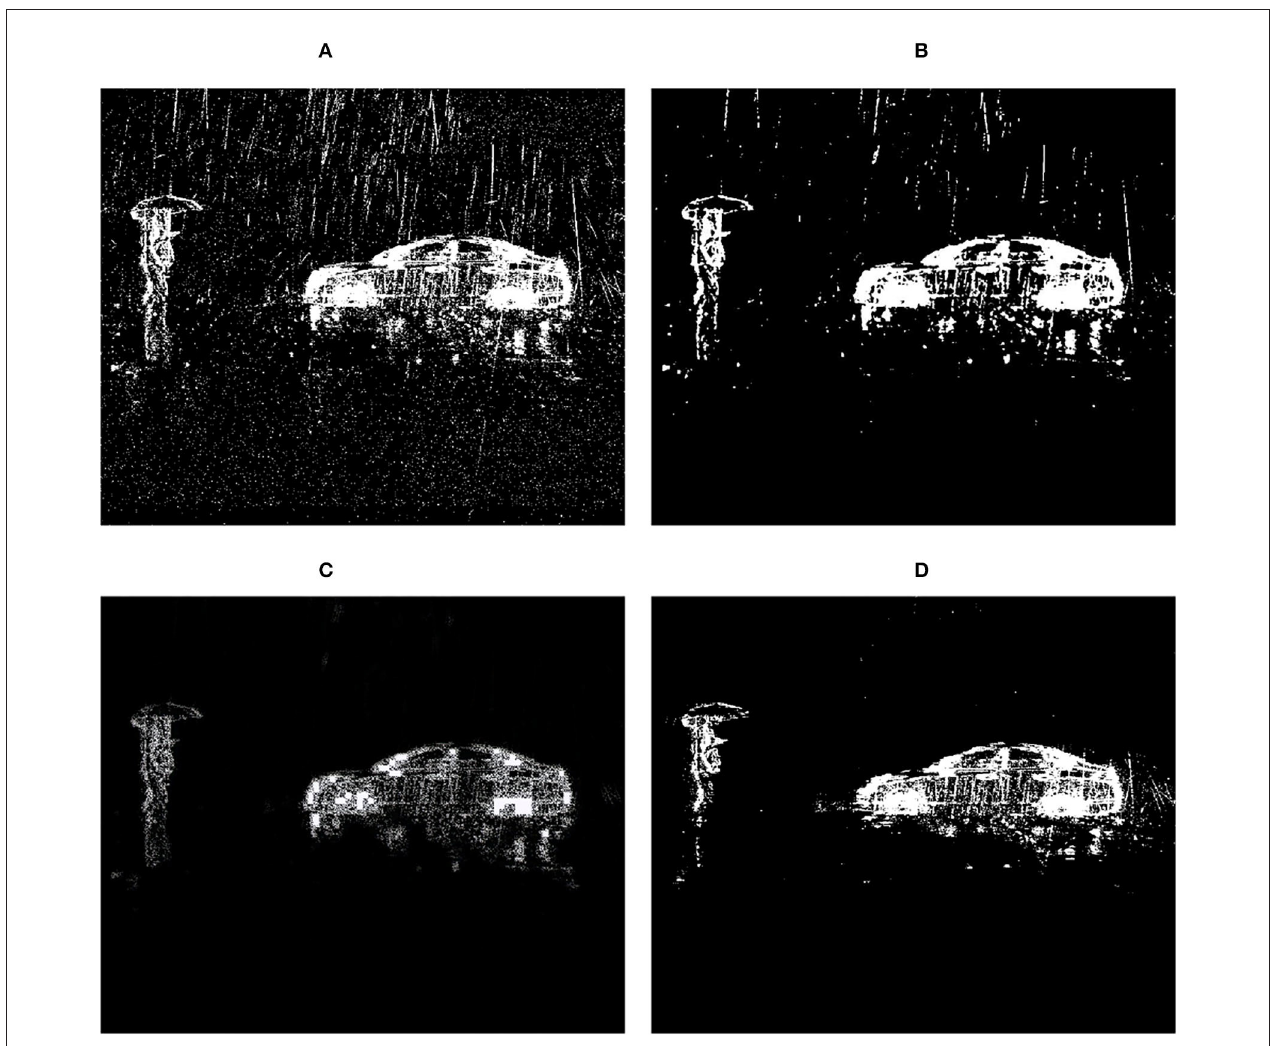
FIGURE 2 | A rainy DVS frame and the deraining results of two existing algorithms and our approach. Observe MCSC (Li M. et al., 2018) only removes part of the rain streaks and ReMAEN ( Yang and Lu, 2019) failed to preserve most texture details of background objects. (A) Input. (B) MCSC. (C) ReMAEN. (D)